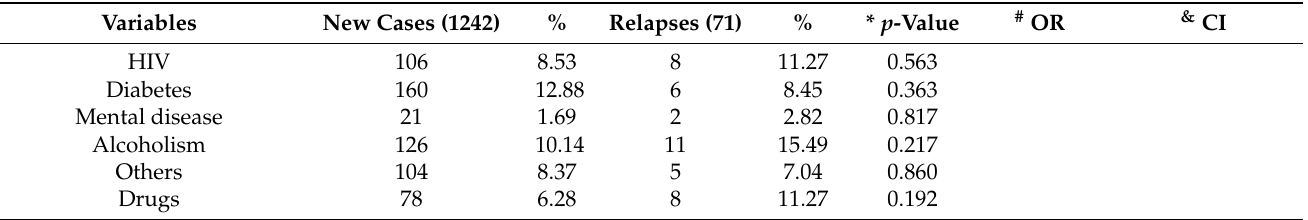
Table 4. New cases versus relapses (conditions and outcome) in Ananindeua, Par á from 2018 to